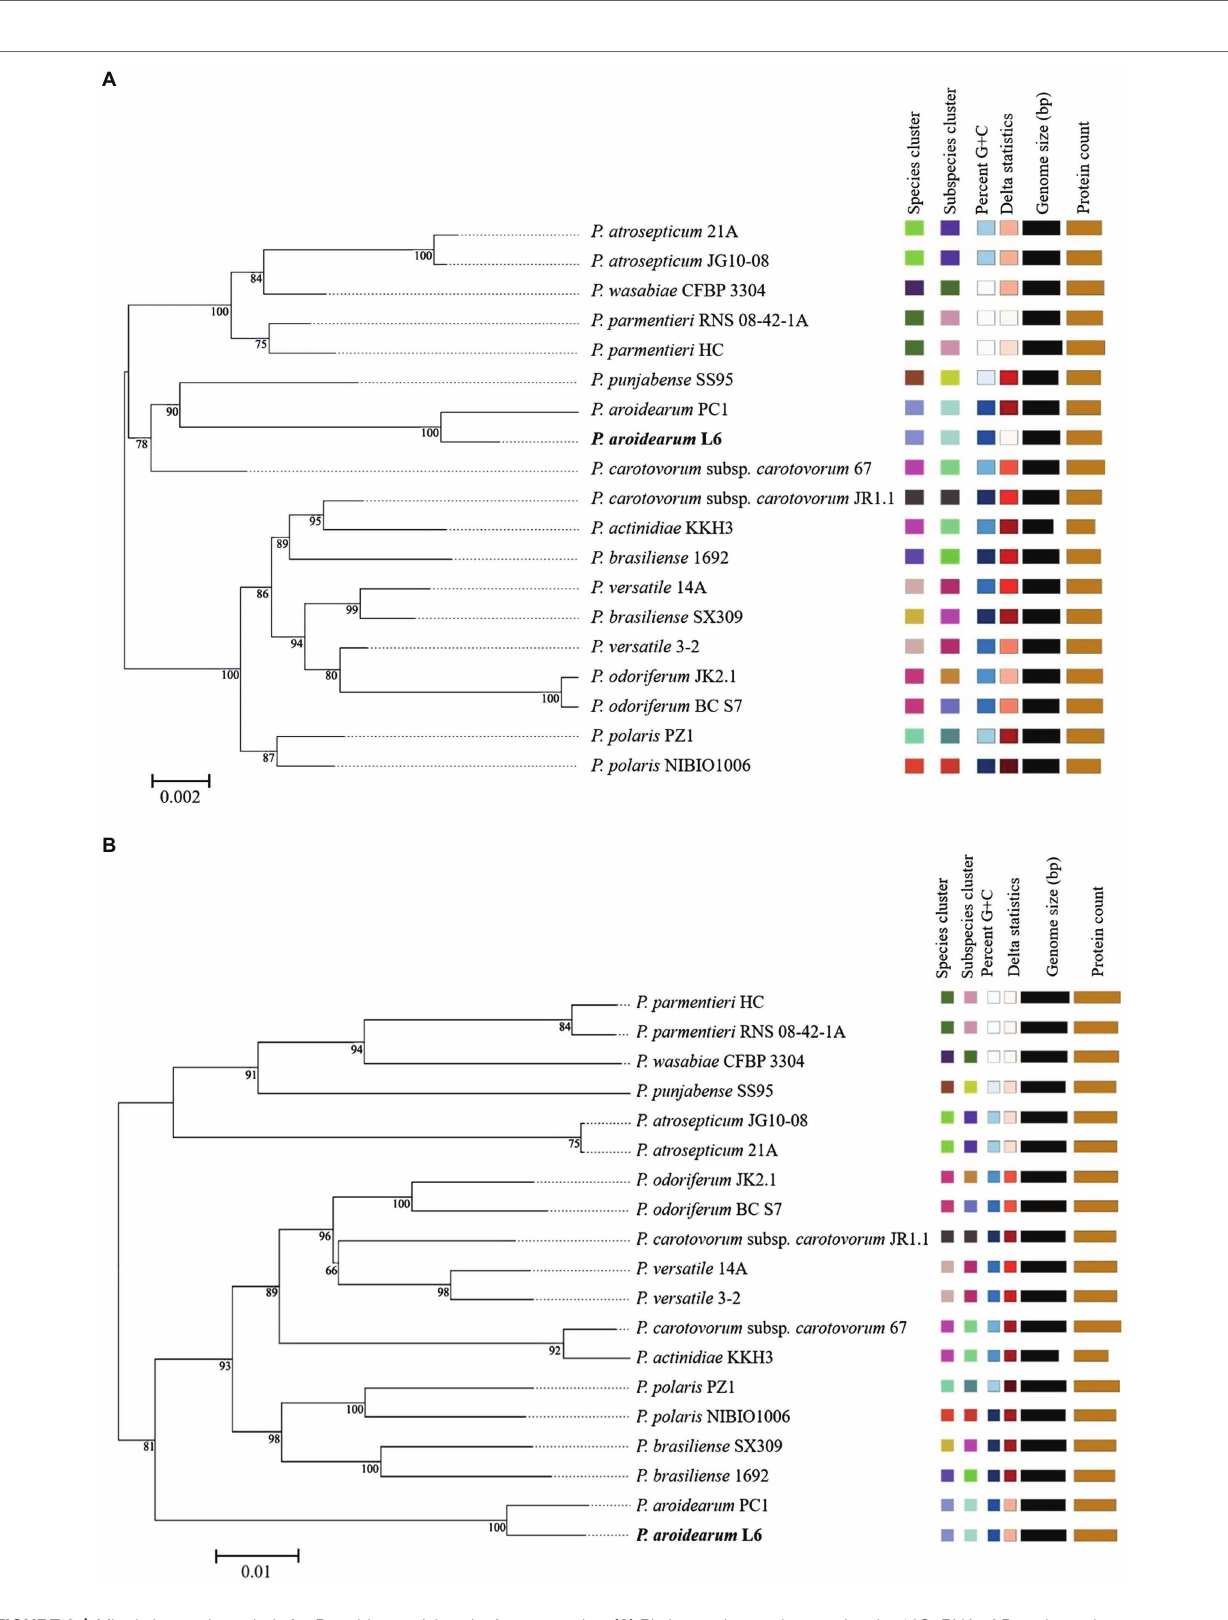
FIGURE 2 | ML phylogenetic analysis for P. aroidearum L6 and reference strains. (A) Phylogenetic tree drawn using the 16S rRNA of Pectobacterium spp. (B) Phylogenetic tree drawn using the genomes of Pectobacterium spp. Bootstrap values are indicated in % of